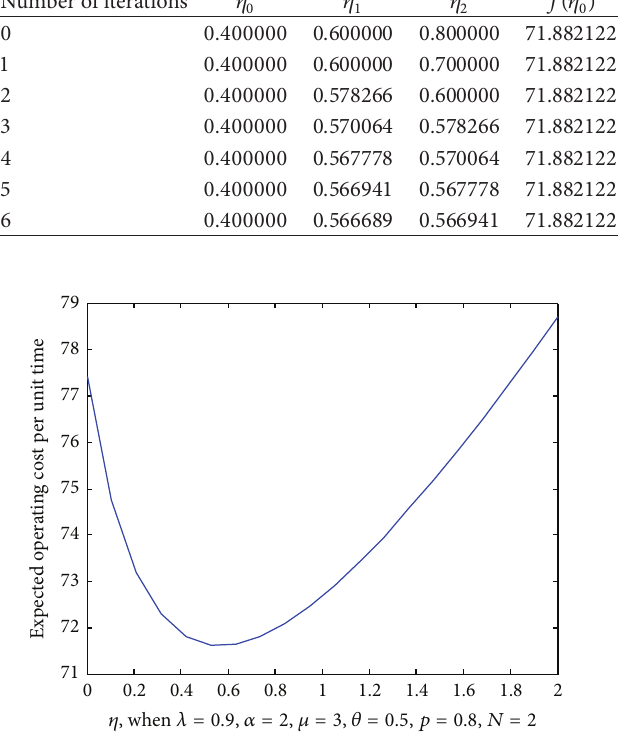
Figure 7: Effect of 𝜂 on the expected operating cost per unit